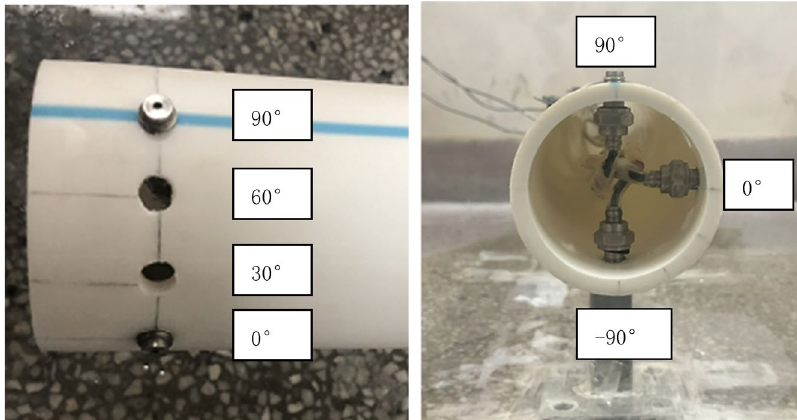
Figure 2. Position of pressure probe.